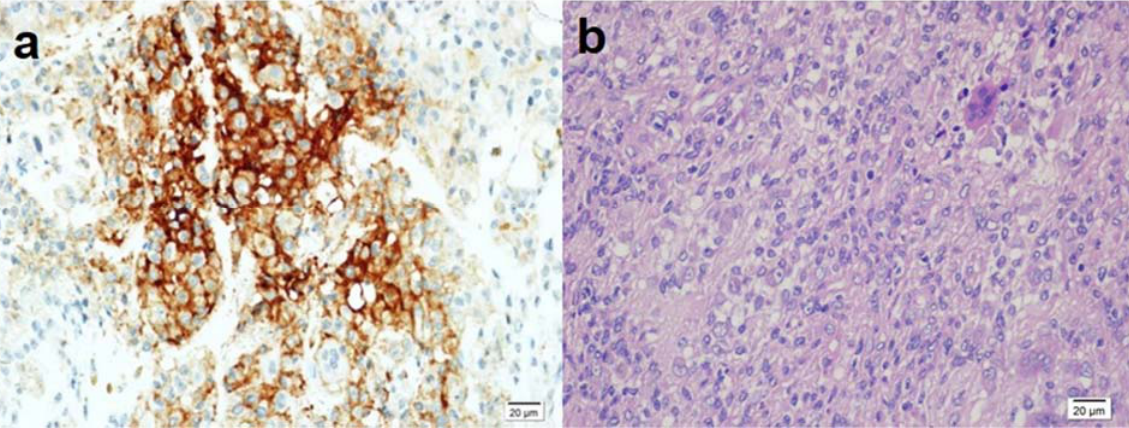
Figure 1. ( a ) Positive expression of PD-L1 in mononuclear cells, 400 × magnification; ( b ) H&E staining of the same sectional area, 400 × magnification.